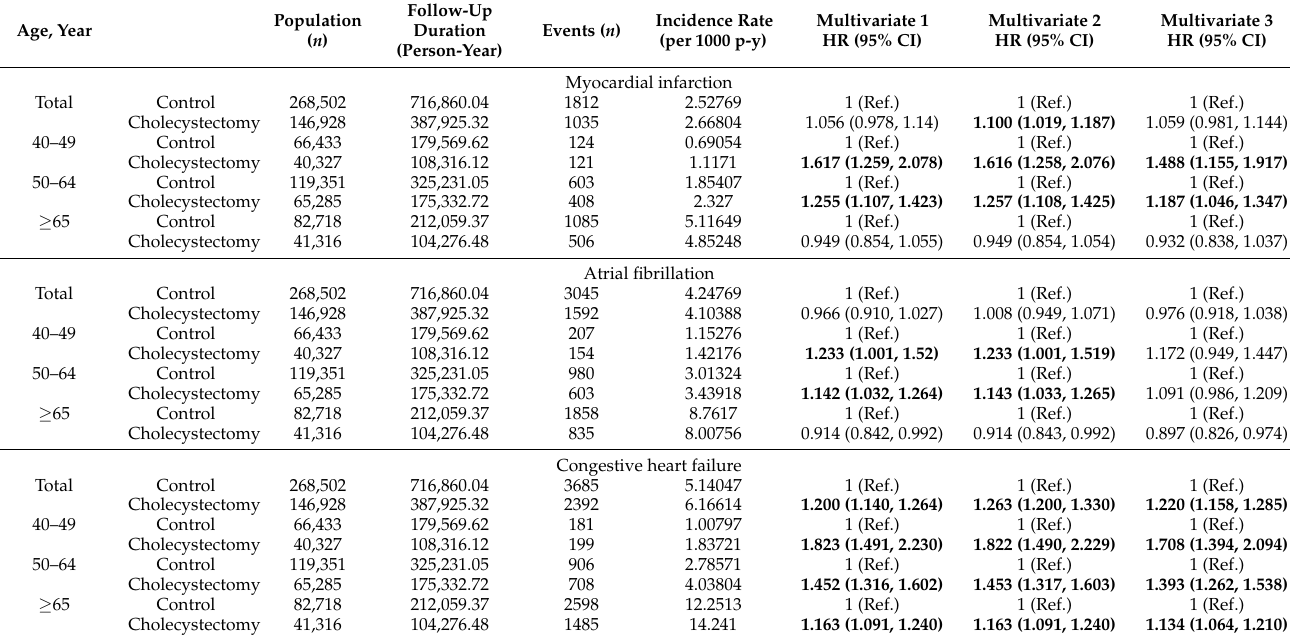
Table 4. Incidence of heart disease in the cholecystectomy and control groups according to age-group classification. Age, Year